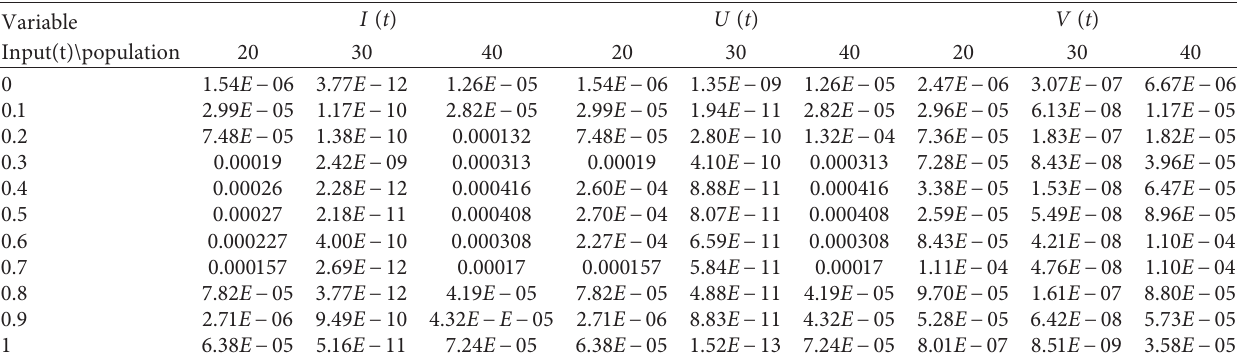
Table 8: Problem 1: analysis based on the variation of population